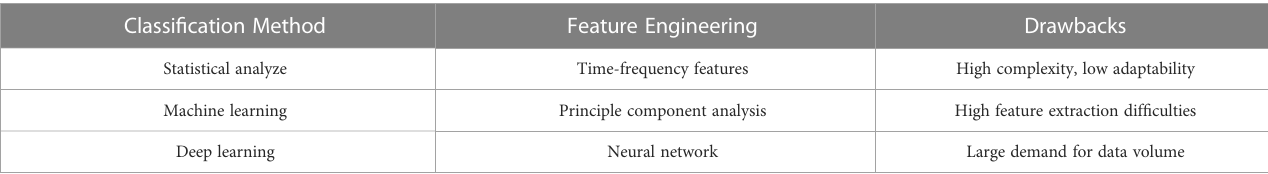
TABLE 1 Comparison of common ship-radiated noise classi fi cation